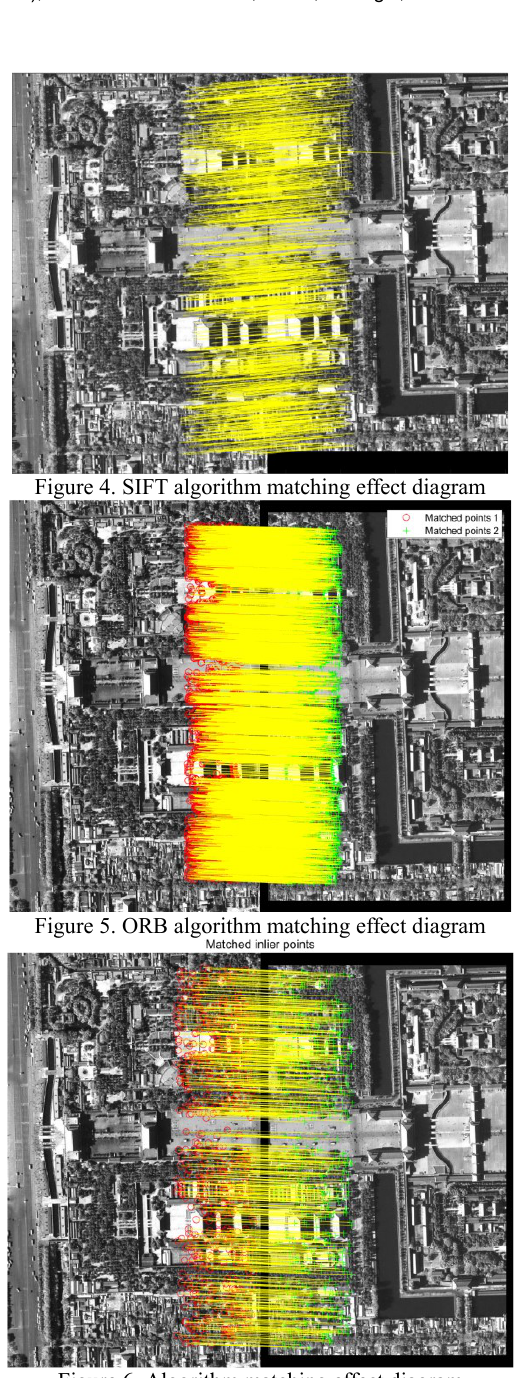
Figure 6. Algorithm matching effect diagram